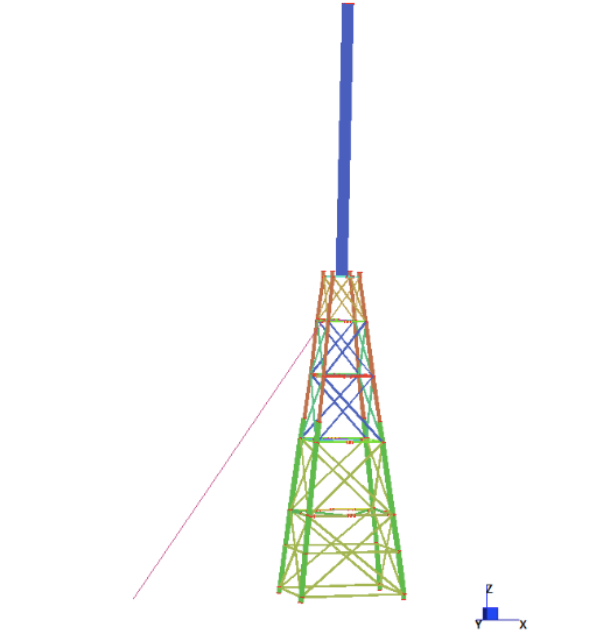
Figure 18. Mooring line configuration model